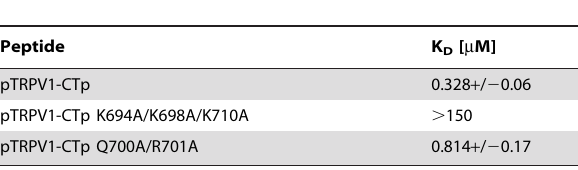
Table 3. Summary of equilibrium dissociation constants (K D ) and their standard deviations estimated by fluorescence anisotropy measurement of TRPV1-CT proximal region (688– 718) wild-type (peptide pTRPV1-CTp) and its mutants.